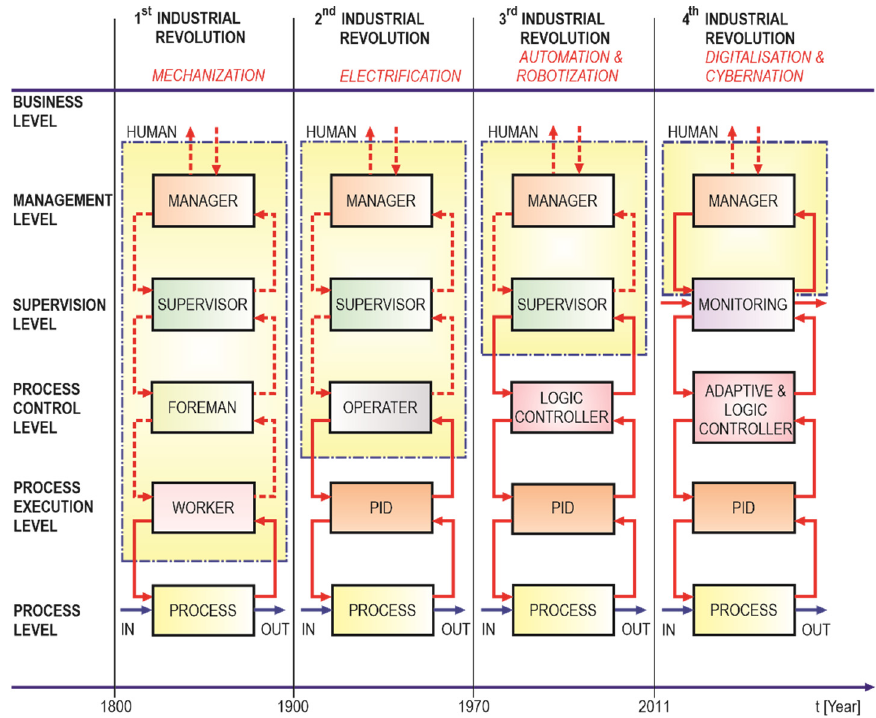
Figure 13. Evolution of the human’s role in manufacturing systems over time [65].